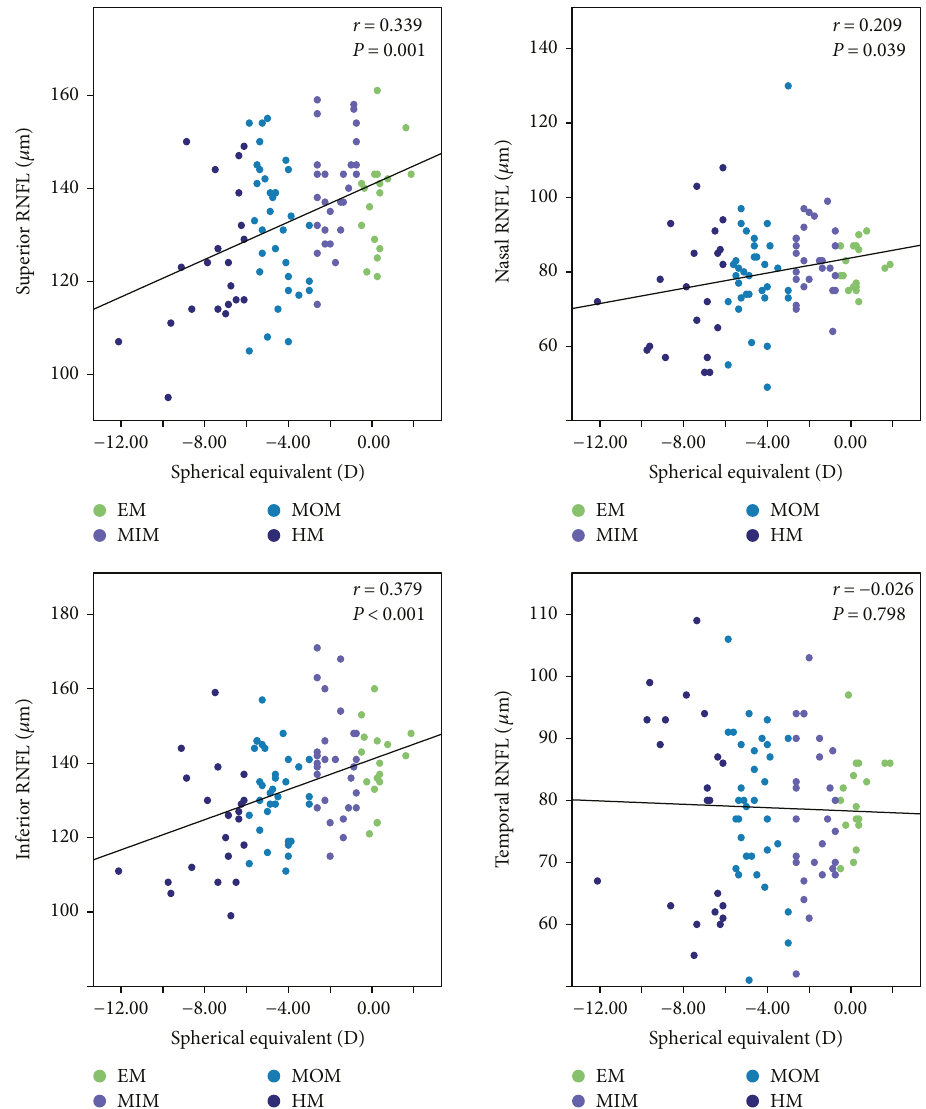
Figure 3: Scatterplots illustrating the linear (black line) associations between spherical equivalent (D) and optical coherence tomography angiography (OCTA) peripapillary quadrant (superior, nasal, inferior, and temporal) RNFL thickness ( μ m) measurement of the studied eyes. r , correlation coe ffi cient from the Spearman rank correlation analysis; EM, emmetropia, MSE 0.50D to − 0.50D; MIM, mild myopia,